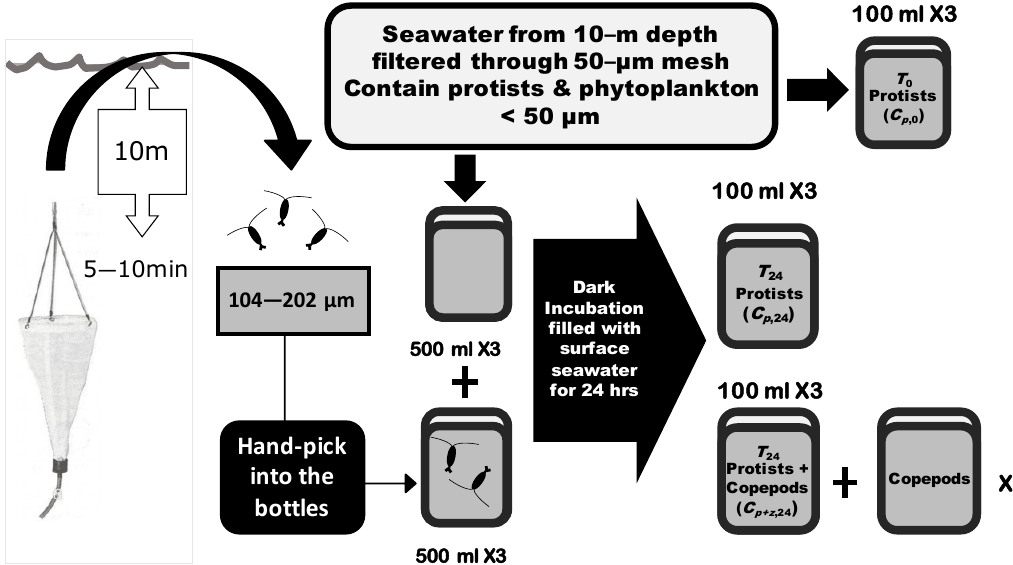
Figure 2. Flowchart of shipboard grazing experiments. Plankton samples preserved for each experiment included (1) heterotrophic protists and phytoplankton at the beginning of incubation ( T 0 Protists, C p ,0 ); (2) heterotrophic protists and phytoplankton after 24 h of incubation without copepod addition ( T 24 Protists, C p ,24 ); (3) heterotrophic protists and phytoplankton after 24 h of incubation with copepod addition ( T 24 Protists + Copepods, C p+z ,24 ); (4) copepods added into the experimental bottles. The incubations with and without copepods were conducted in three replicates ( × 3) of 500 mL bottles. The density of heterotrophic protists and phytoplankton at the beginning C p ,0 , the density of heterotrophic protists and phytoplankton without and with the addition of copepods after 24 h of incubation with C p ,24 and C p+z ,24 , and the copepod community were collected from the three replicates ( × 3) of incubated bottles (100 mL from each bottle).